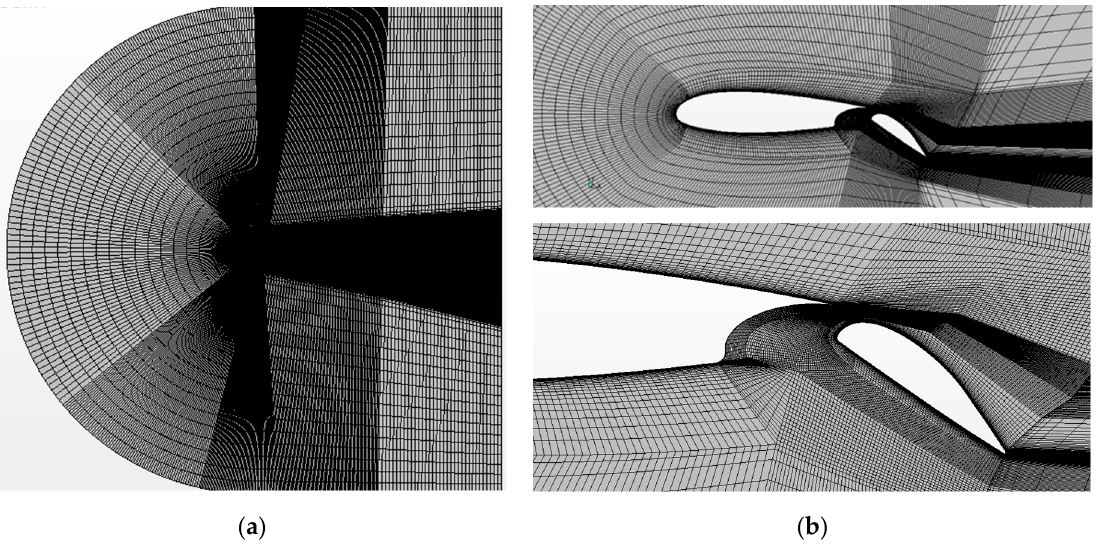
Figure 6. Two-dimensional mesh for flapped airfoil analysis: ( a ) Global overview of C-shape domain; ( b ) mesh details around the airfoil and flap. Table 4. Relevant data for 2D analysis.